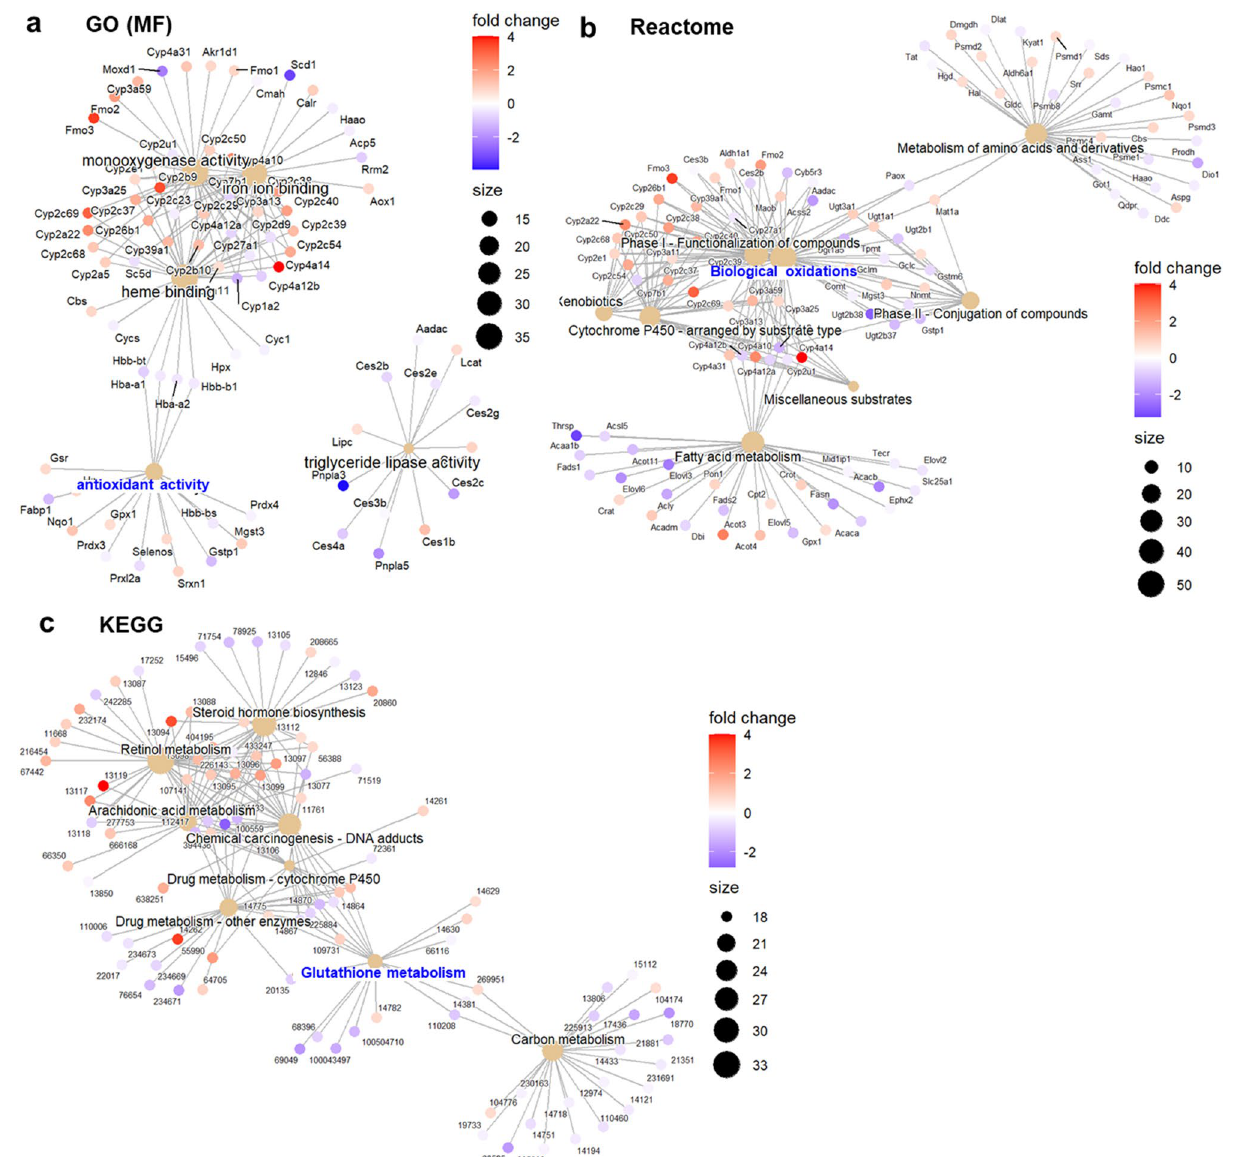
Figure 5.. The linkages of genes and biological concepts changed in the livers of MG mice compared to GC mice. GC, control mice on Earth; MG, mice under microgravity in space. Biological concepts were from Gene Ontology (GO) terms ( a ), Reactome ( b ), or KEGG ( c ) pathways as a network. Dot color, the fold change of enrichment in the livers of MG mice compared to GC mice; Size, the node size. Pathways colored blue